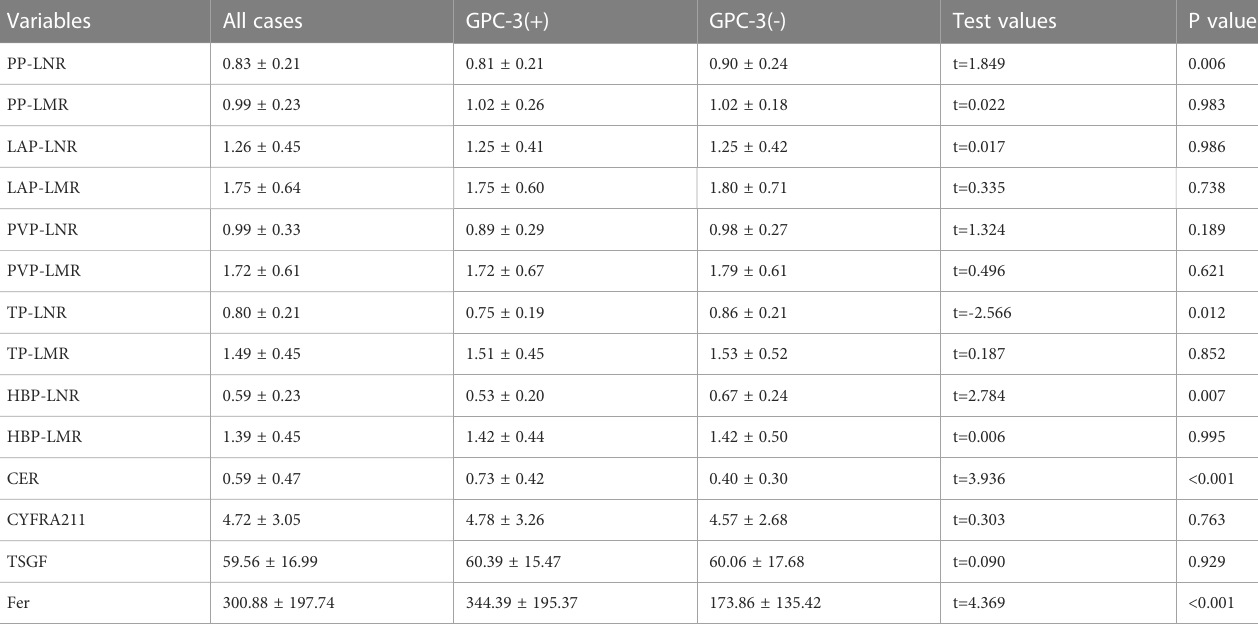
TABLE 4 The univariate analysis between GPC-3 expression with enhanced-MRI quantitative parameters and clinical factors in training cohort (continuous variables). Variables